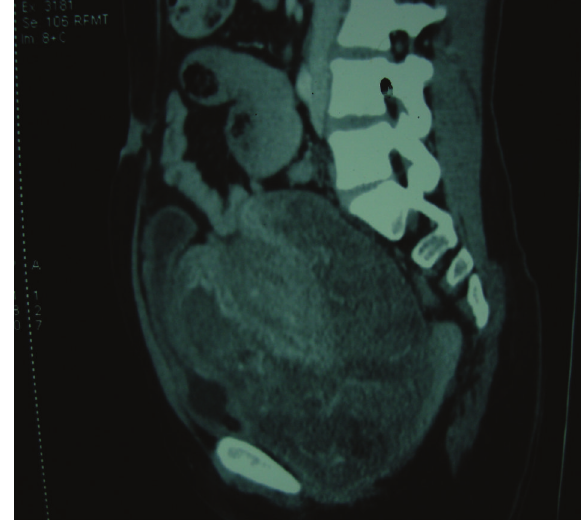
Figure 2: Sagital section computed tomography showing the lesion compressing the bladder anteriorly and the rectum posteriorly maintaining the intervening fat planes.